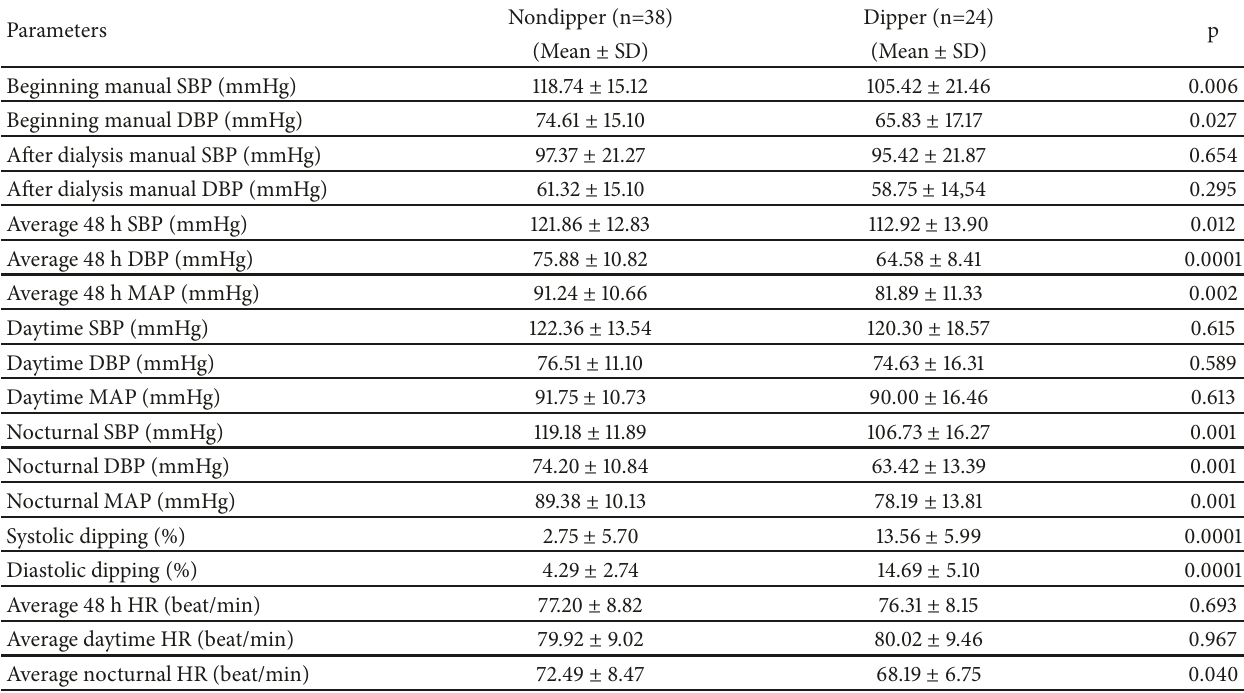
Table 2: Results of ambulatory blood pressure monitoring in nondipper and dipper